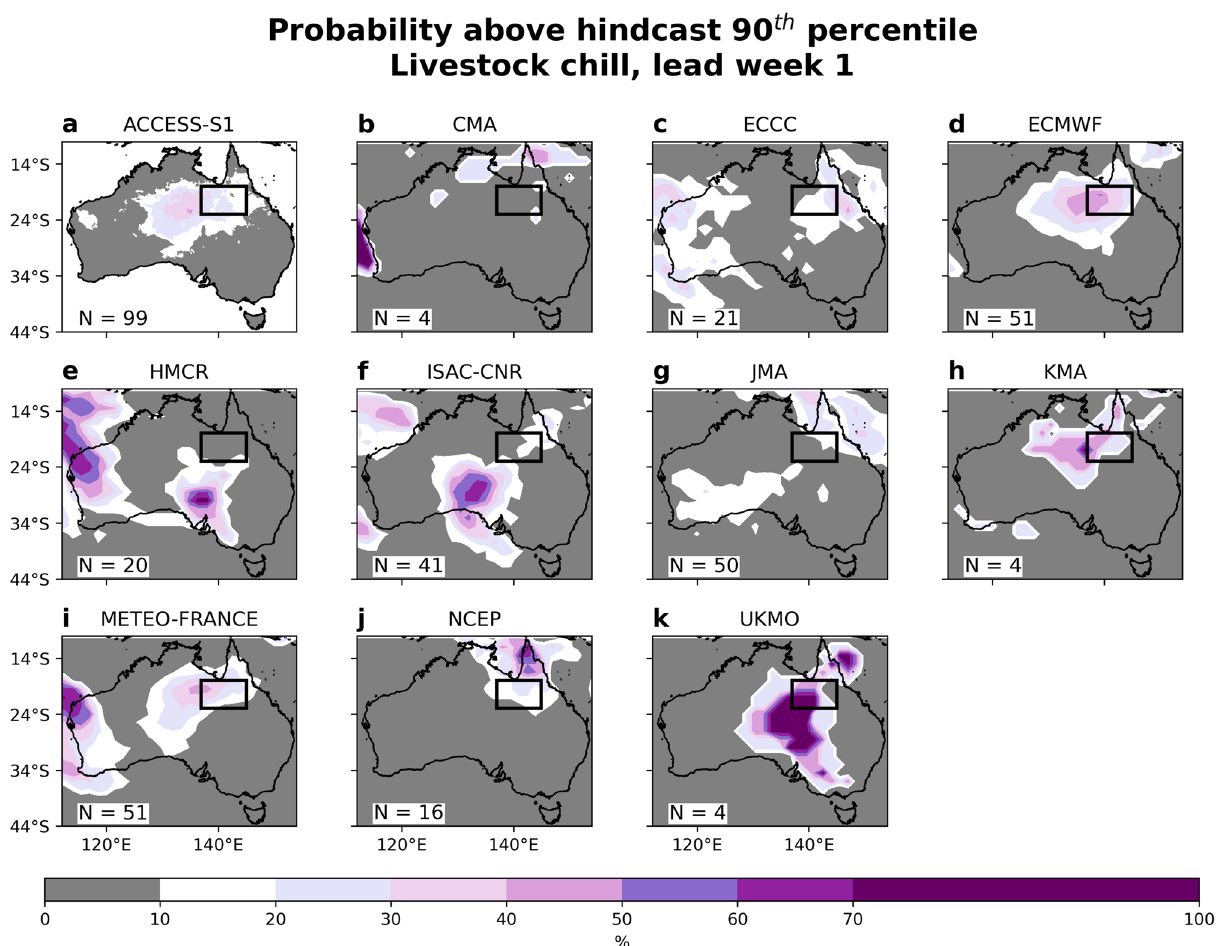
Figure 4. Lead week 1 forecast of the chances for extreme livestock chill conditions from ACCESS-S1 and ten S2S forecast systems. Shown are the model forecasts of livestock chill index being above their respective hindcast multi-year daily 90th percentile, targeted to the week of 31 January to 6 February 2019, for ( a ) ACCESS-S1, ( b ) CMA, ( c ) ECCC, ( d ) ECMWF, ( e ) HMCR, ( f ) ISAC-CNR, ( g ) JMA, ( h ) KMA, ( i ) Météo-France (CNRM), ( j ) NCEP and ( k ) UKMO. Each model’s hindcast years are listed in the Table 1, and the ensemble forecast size is shown in the bottom left corner of the